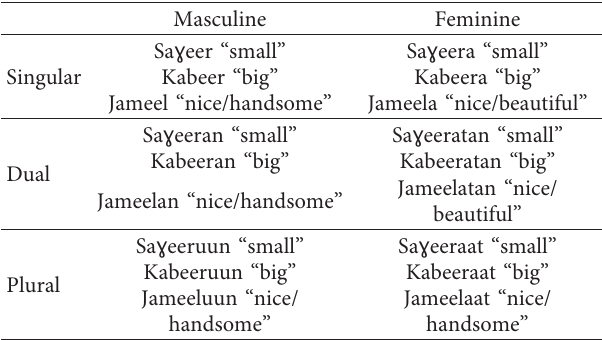
Table 2: Sample adjectives by gender and number.